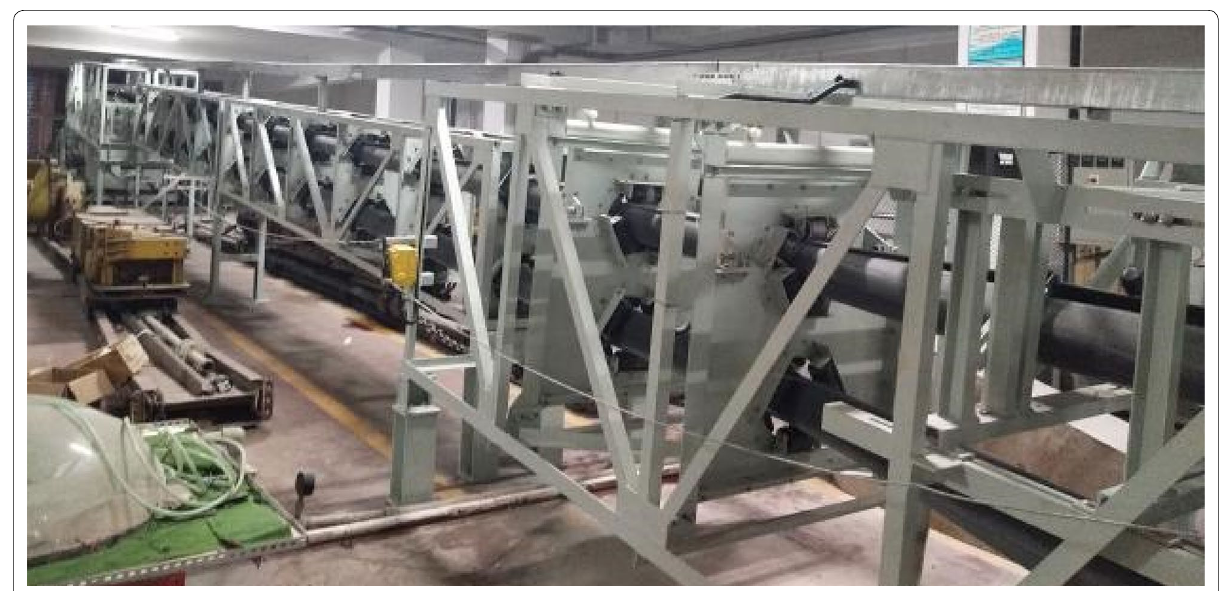
Figure 5 The experimental device of the pipe conveyor